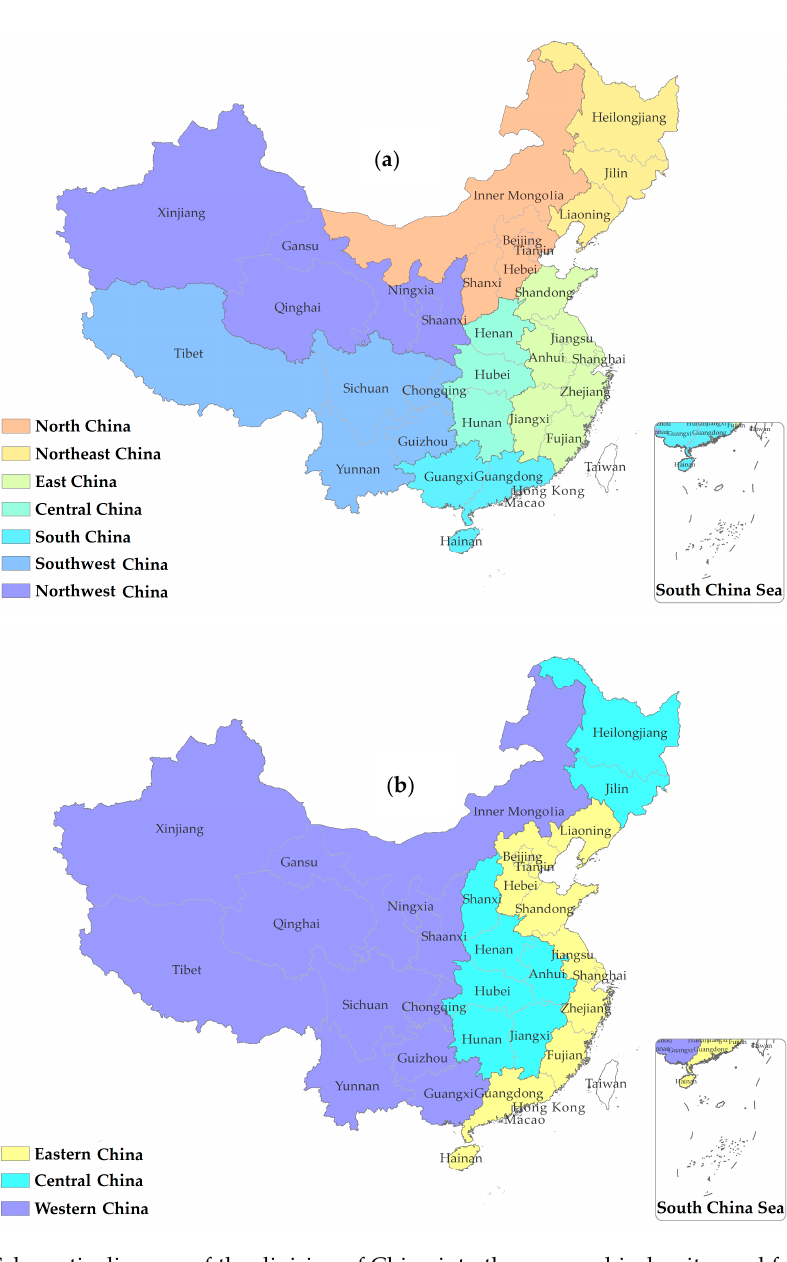
Figure 1. Schematic diagram of the division of China into the geographical units used for analyses showing ( a ) the seven geographical regions; and ( b ) three economic zones. Map source: Sino Maps Press.